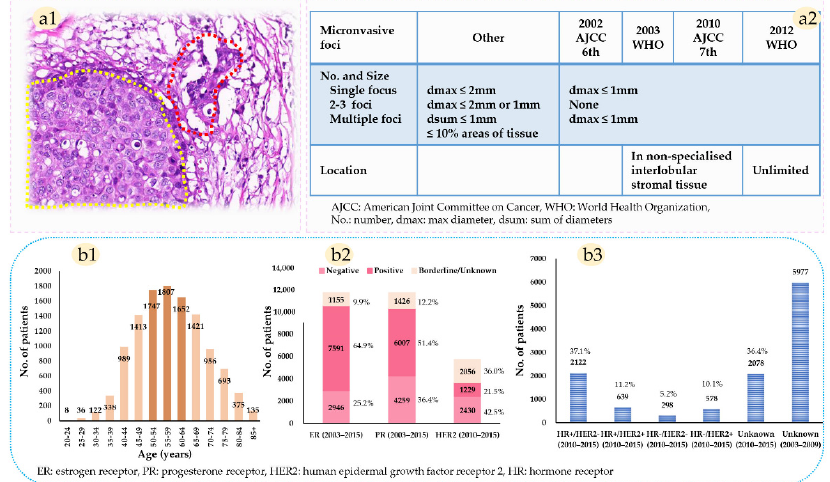
Figure 2. The diagnostic criterion of microinvasive breast cancer (MBC) and major clinicopathological characteristics of the eligible population. ( a1 ) MBC is defined as ductal carcinoma in situ (yellow dash line) with one or more foci of tumor cells (red dash line) extending beyond the basement mem- brane. No focus is larger than 1 mm in max diameter. ( a2 ) Evolution of the diagnostic criterion for